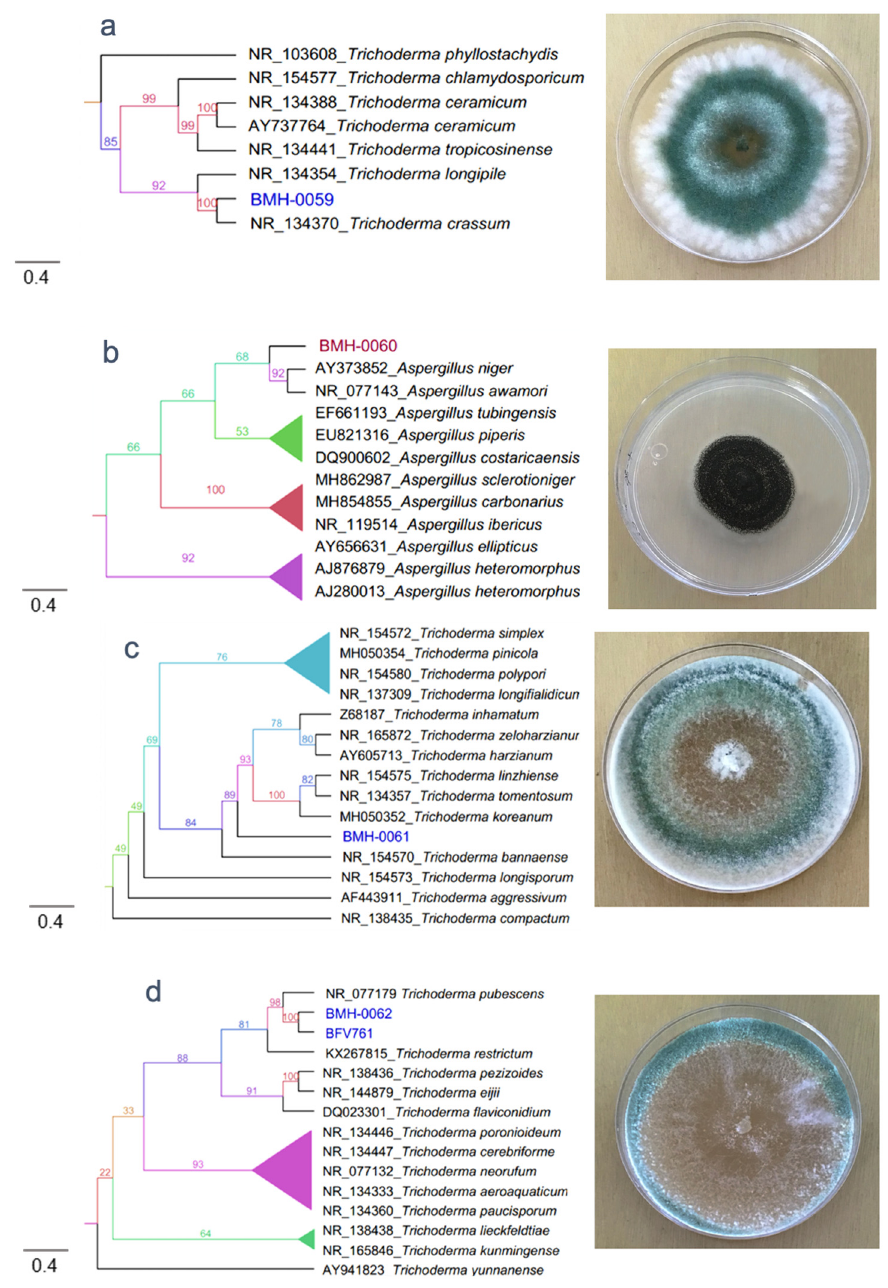
Figure 1. Phylogenetic tree generated by FastTree analysis using a MAFFT alignment of ITS2-4 nucleotide sequences obtained from the type material. The tree includes strains related to ( a ) Strain BMH-0059 (left) is identified as T. crassum . ( b ) Strain BMH-0060 (left) is identified as related to A. awamori . ( c ) Strain BMH-0061 (left) is identified as Trichoderma sp. ( d ) Strain BMH-0062 (left) is identified as closely related to T. pubescens . Bootstrap values ( > 50%) are labeled in color on the branch nodes. A representative image of the colony is shown on the right side of each alignment. The bar indicates 4 percent of changes per site.